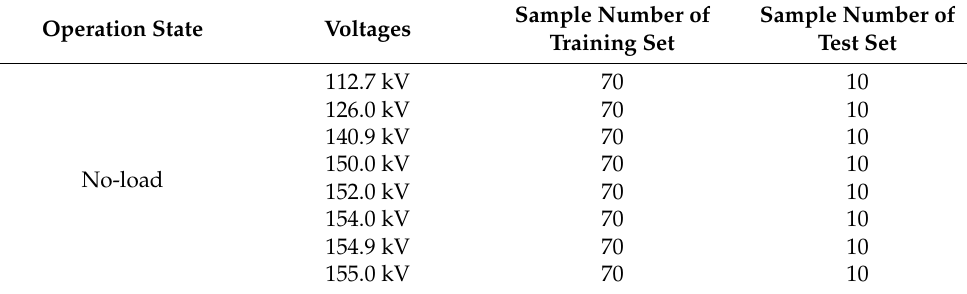
Table 3. Sample of no-load